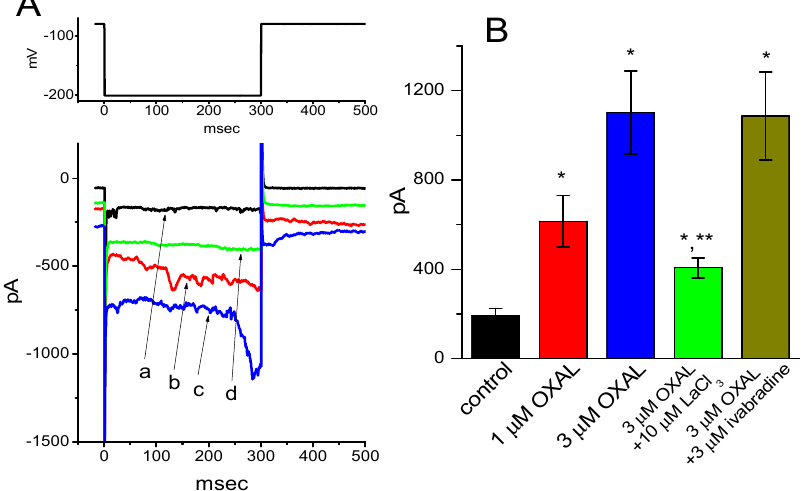
Figure 7. The effect of OXAL on I MEP in Rolf B1.T olfactory ensheathing cells. In these experiments, cells were bathed in Ca 2+ -free Tyrode’s solution and the pipette was filled with K + -containing solution. (A) Representative I MEP traces obtained in the control (a) and during the exposure to 1 μ M OXAL (b), 3 μ M OXAL (c), or 10 μ M OXAL (d). The voltage protocol used is indicated in the upper part. Note that the presence of OXAL produces a progressive increase in I MEP . ( B ) Summary bar graph showing the effects of OXAL, OXAL plus LaCl 3 , and OXAL plus ivabradine on I MEP in these cells (mean ± SEM; n = 7–8 for each bar). * Significantly different from control ( p < 0.05) and ** significantly different from 3 μ M OXAL along group ( p < 0.05).